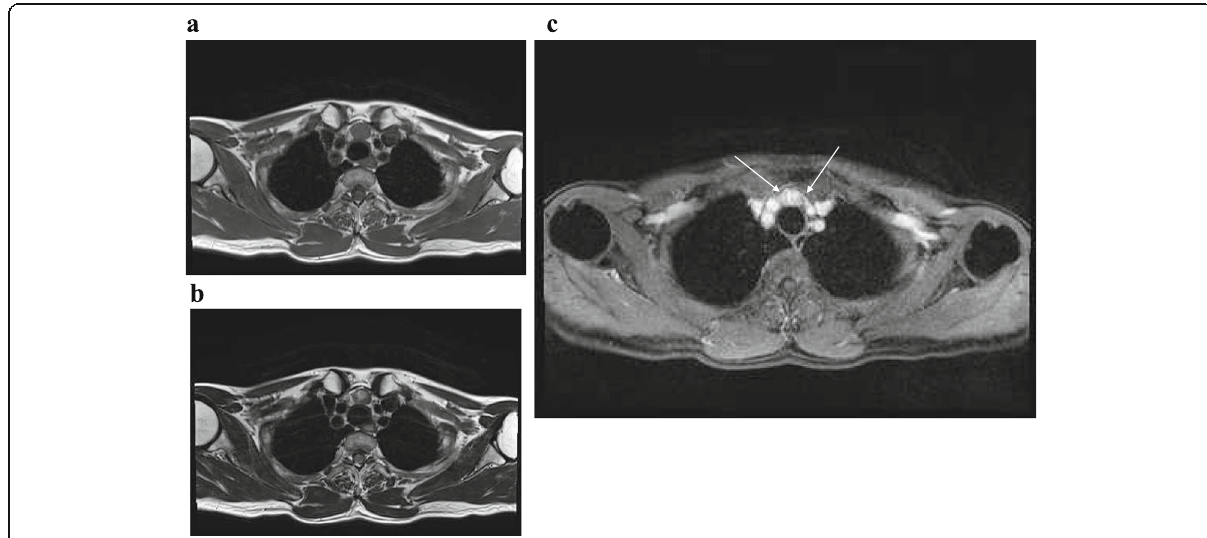
Fig. 2 MRI images of ectopic mediastinal thyroid tissue. a Low signal intensity on T1-weighted images. b High signal intensity on T2-weighted images. c Enhanced MRI showing stronger enhancement. Arrows show tumor-feeding arteries arising from the vessels in the thorax